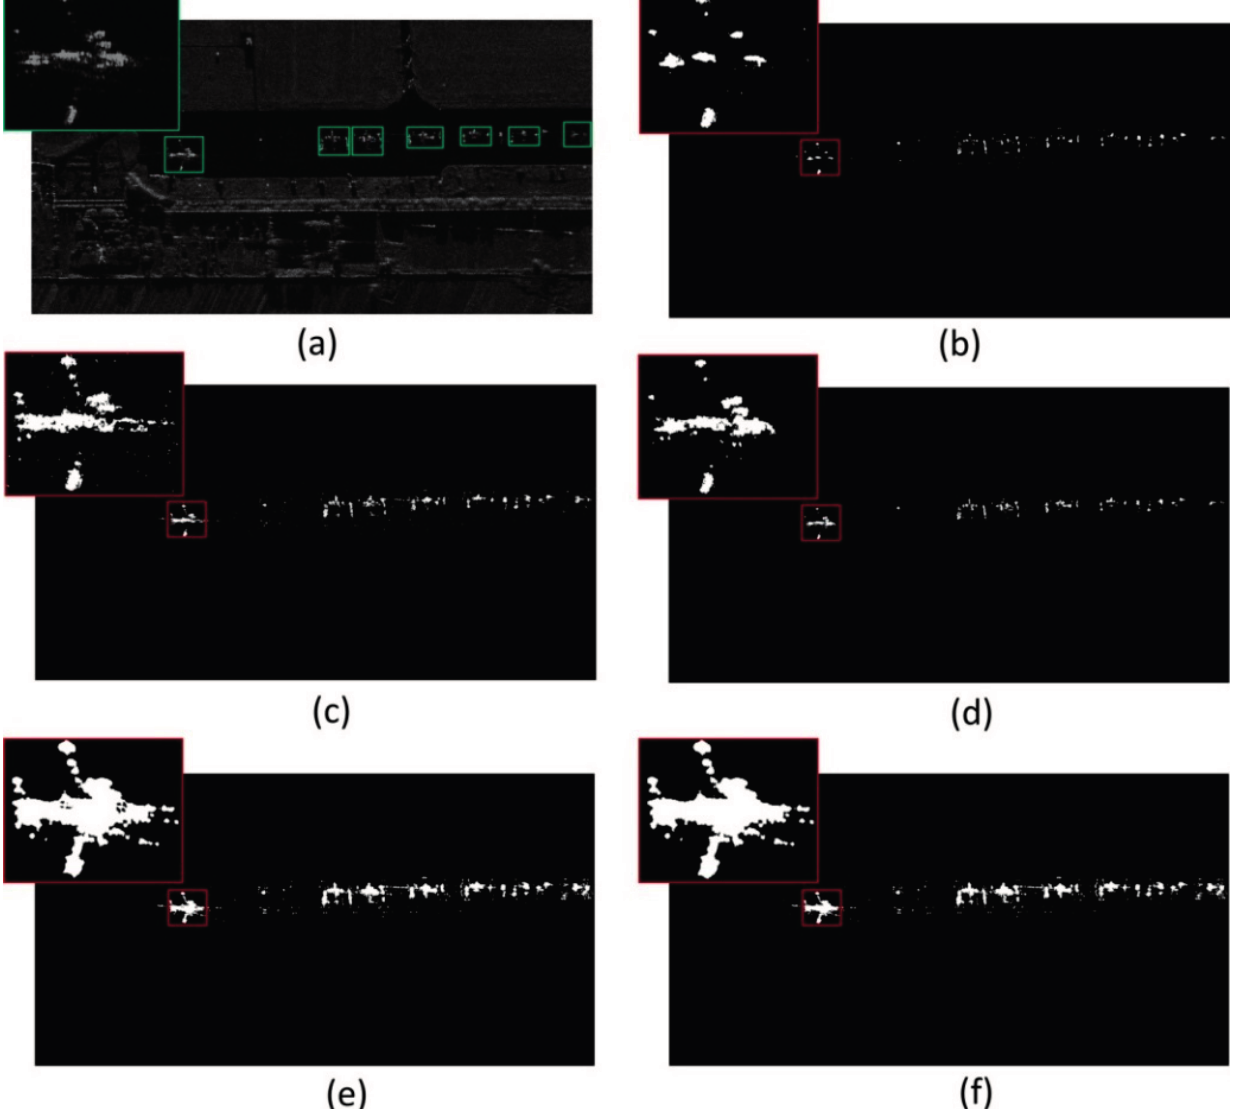
Figure 13. Results of different detectors in multi-targets case. ( a ) is the original SAR image; ( b ) is the result of VI-CFAR detector; ( c ) is the result of SCCA-CFAR detector; ( d ) is the result of TL-CFAR detector; ( e ) is the result of LED detector; ( f ) is the result of GTS detector. The regions labeled by green rectangles in ( a ) are the aircraft targets in the SAR image ( a ). In addition, the images on the top left corner are the original resolution of the regions which are labeled by red rectangle in the corresponding images. Specially, such region is labeled by a green rectangle in ( a